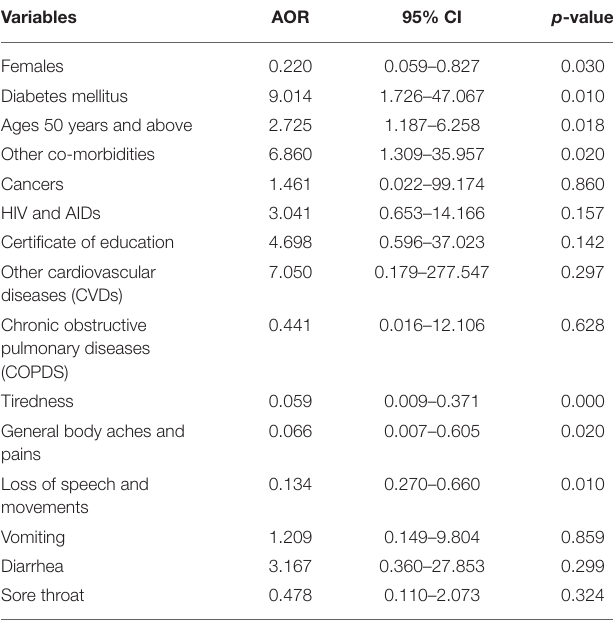
TABLE 3 | The adjusted Odds Ratios for factors associated with mortality among COVID-19 patients treated at Gulu Regional Referral